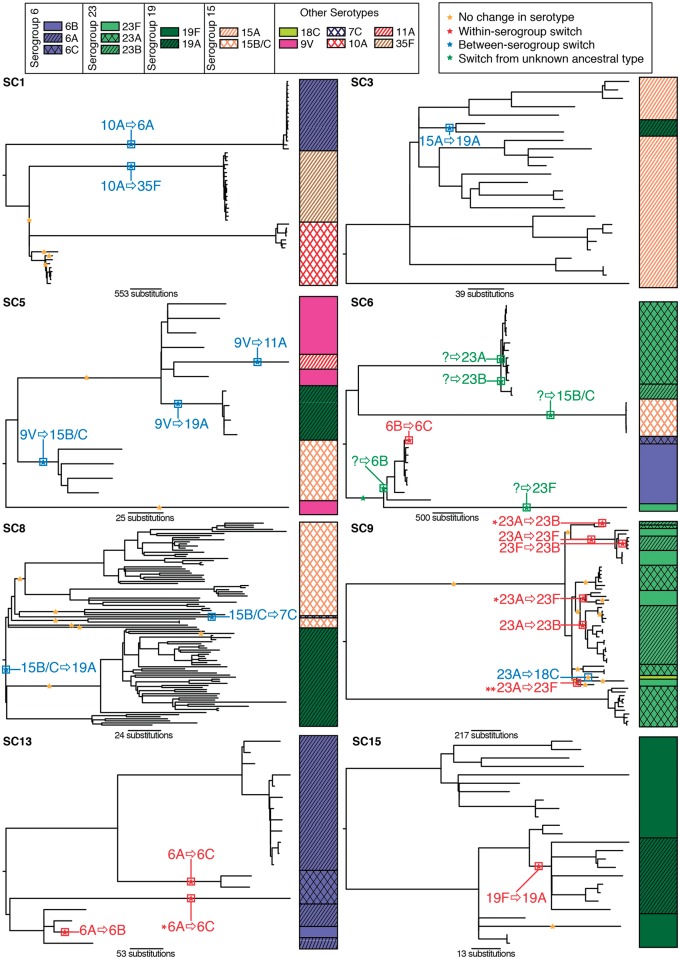
Serotype switching events within sequence clusters.The evolution of each of the monophyletic sequence clusters highlighted in Fig. 1 was reconstructed from a whole genome alignment (see Methods). The resulting phylogenies are annotated with the serotype of the isolates. Stars on the branches of each phylogeny mark instances where putative recombinations affected the cps locus. These stars are coloured according to the inferred consequences of the recombination. Where these sequence imports led to a change in serotype, this is annotated: in red for within-serogroup switches, in blue for between-serogroup switches, and in green, where the ancestral serotype cannot be reliably determined.